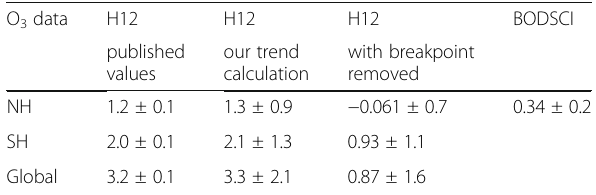
Table 1 Tropical widening trends from the H12 method (° latitude per